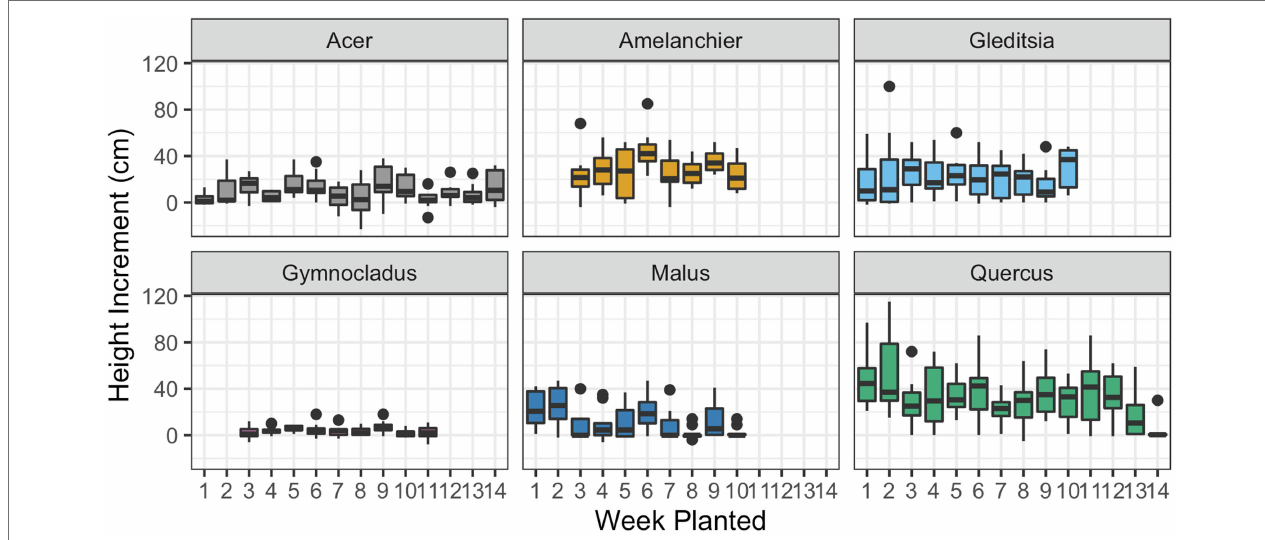
FIGURE 6 | Incremental height growth by the time of plantings. Height was measured for each tree at planting and in late fall 2020 and the difference is given here. Box plots show median, interquartile range, and minimum and maximum range for each week of planting. Negative height increments suggest die-back of the terminal stem. There was evidence of a significant effect of planting date on height growth for Malus and Quercus ( p < 0.01; details in text and Table 3